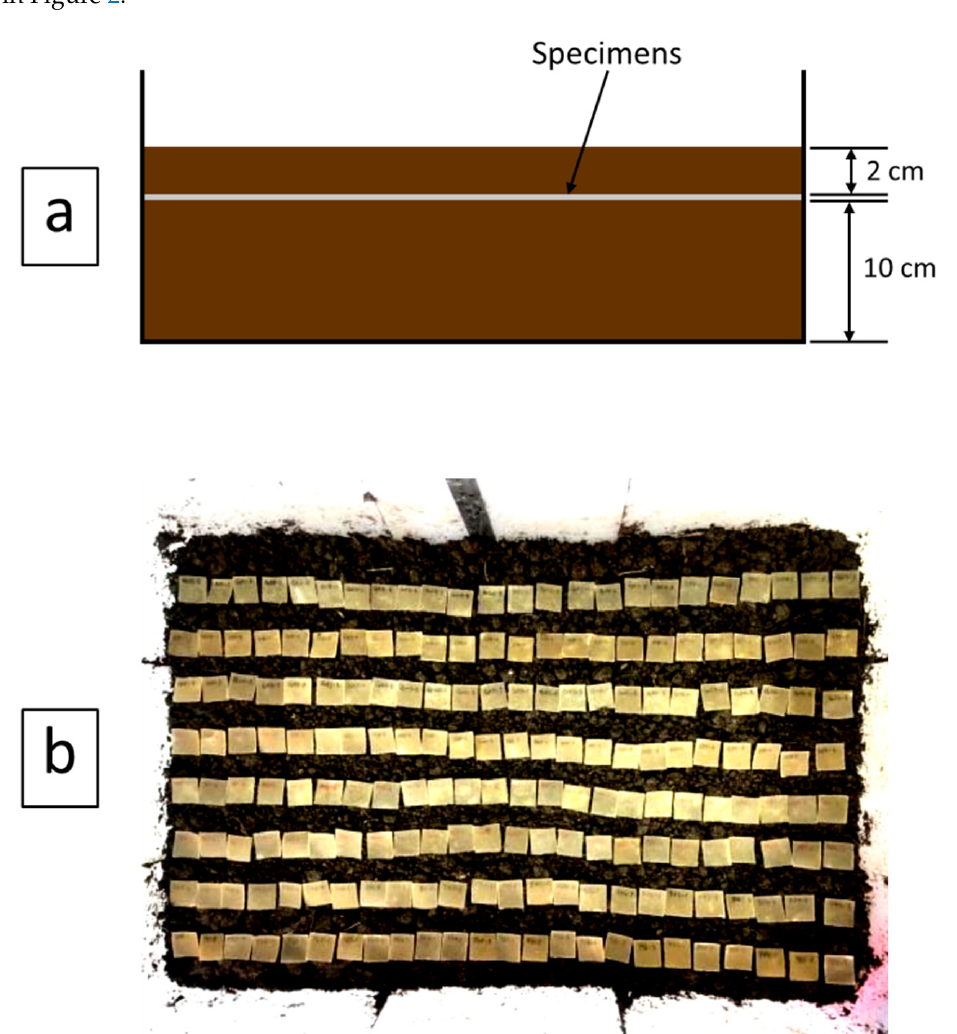
Figure 2 . ( a ) Setup of biodegradability test (side view) and ( b ) actual arrangement of specimens on soil surface before being covered with another 2 cm layer of soil (top view).